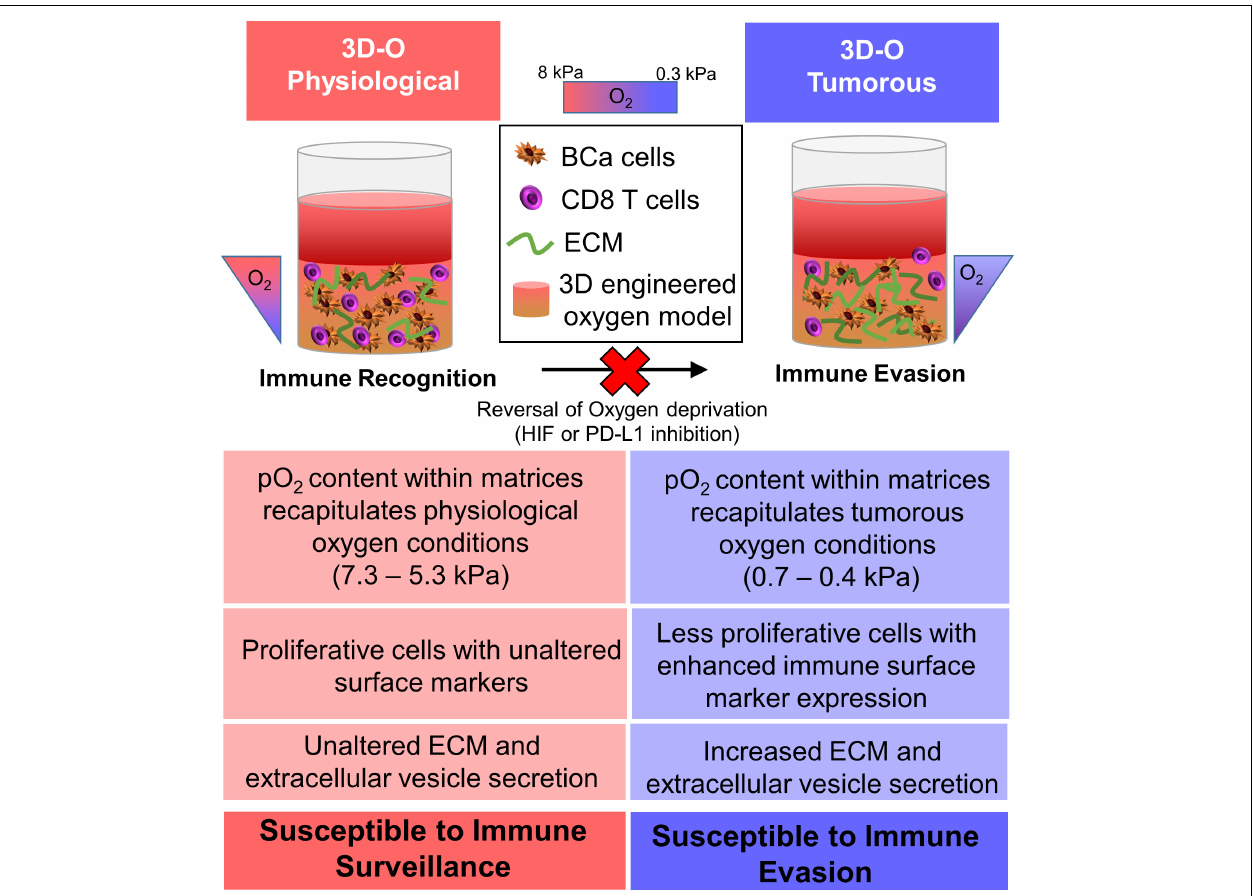
FIGURE 9 | Graphical abstract. The 3D-O model generates physio- (3D-O physiological) and pathophysiological (3D-O tumorous) oxygen levels to understand the role of oxygen availability in tumor-immune interactions. Low oxygen-induced changes within the 3D-O tumorous model supported reduced BCa cell proliferation, increased extracellular matrix protein expression, increased extracellular vesicle secretion, enhanced immune surface marker expression on BCa cells, leading to immune evasion mechanisms compared to the 3D-O physiological model.